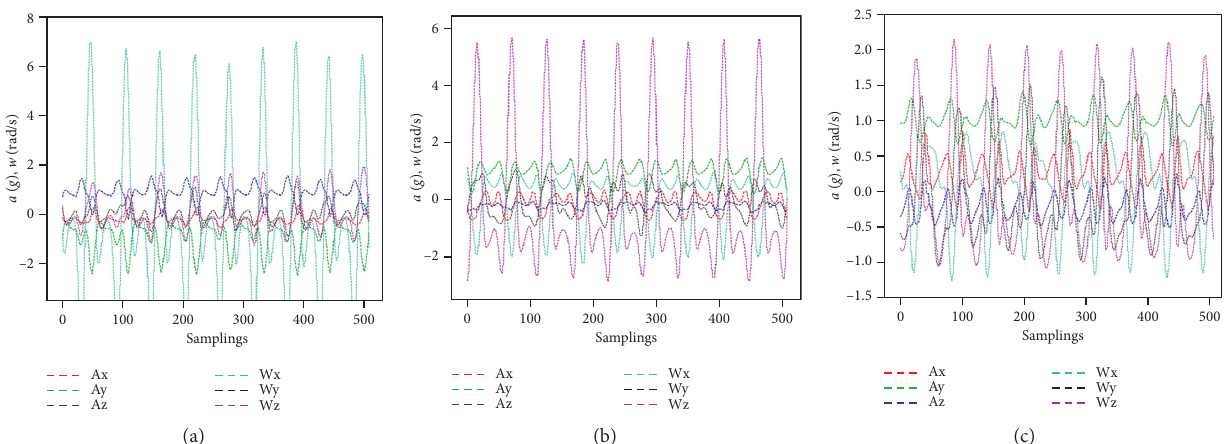
Figure 3: Acceleration and angular velocity data collected under three body parts covering foot (left), calf (center), and thigh (right). In the figures, Ax, Ay, Az, Wx, Wy, and Wz represent the curves of acceleration and angular velocity in the X, Y, and Z directions over time during the acquisition process, respectively.